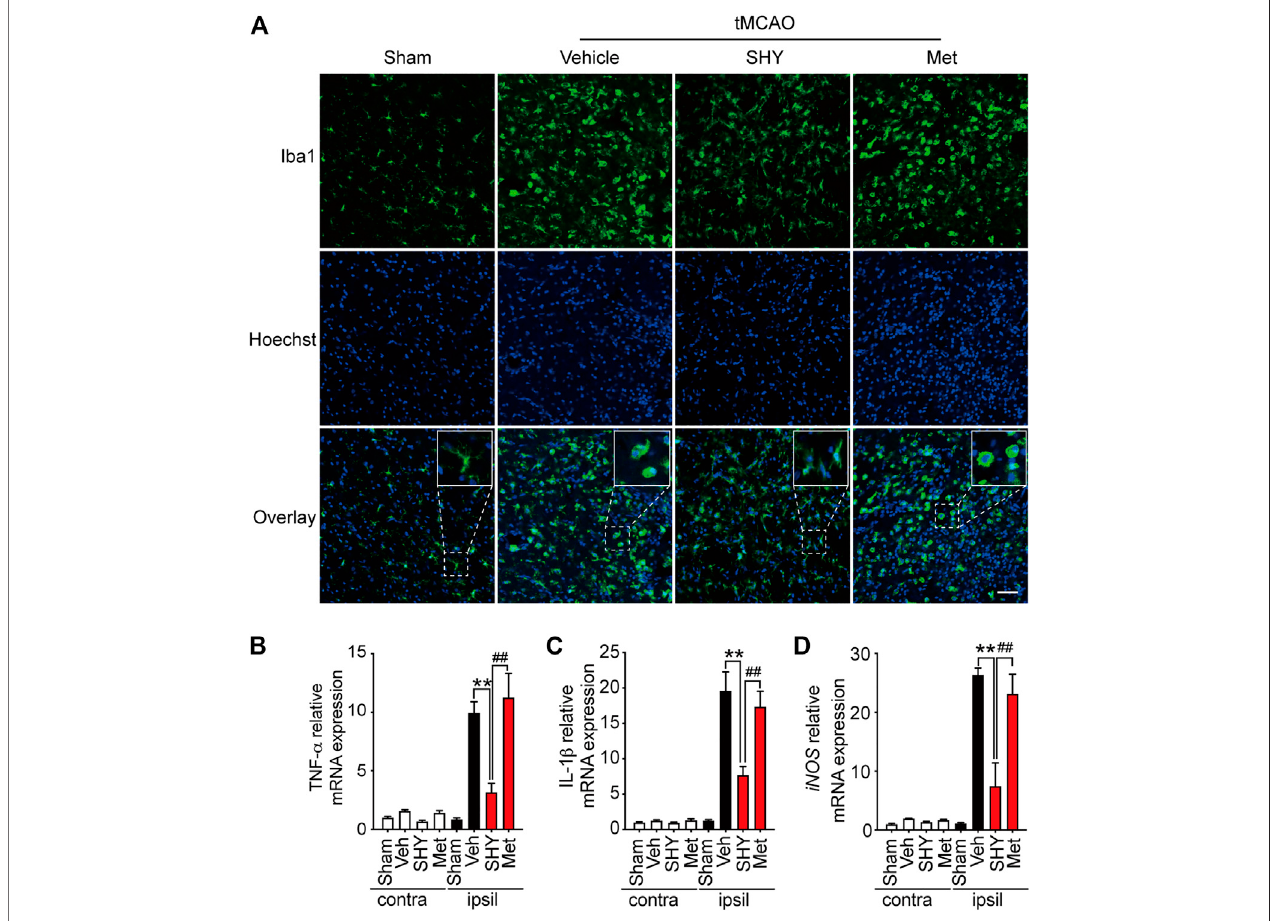
FIGURE6| SHY-01administrationsuppressesmicrogliaactivationintheischemicstriatum.SHY-01(SHY,50 mg/kg)ormetforminhydrochloride(Met,50 mg/kg) was administrated ( i.p. ) daily post reperfusion, saline was used as vehicle control, rats were sacri fi ced at 72 h after tMCAO. (A) Brains were assessed for immuno fl uorescence analysis with frozen sections. Microglia were marked with Iba-1 (green) and nuclei were stained with Hoechst (blue). Representative images detected with confocal microscopy show cellular morphology in the ischemic striatum, n = 4 rats per group, scale bar: 20 μ m. Brains were lysed with Trizol to extract total message RNA, then were reverse transcribed to determine mRNA level of (B) TNF- α , (C) IL-1 β , and (D) iNOS. GAPDH was used as interior reference. Data were expressed as mean ± SD, n = 5 per group, statistical analysis using one-way ANOVA followed by Dunnett ’ s post hoc tests. pp p < 0.01 versus the tMCAO with vehicle treatment group, ## p < 0.01 versus the tMCAO with SHY treatment